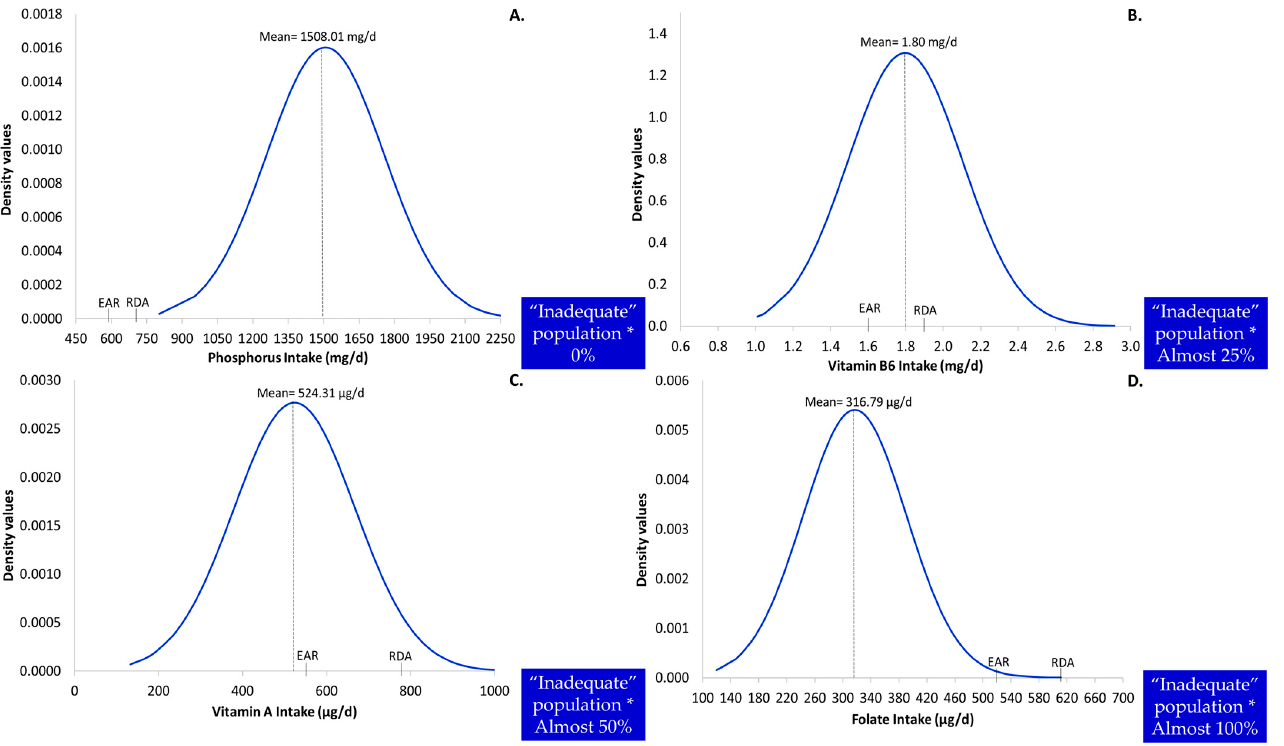
Figure 2. Distribution curve of usual intake for phosphorus ( A ), vitamin B6 ( B ), vitamin A ( C ) and folate ( D ) (n = 608). EAR: Estimated Average Requirement; RDA: Recommended Dietary Allowance; * Rough estimation.